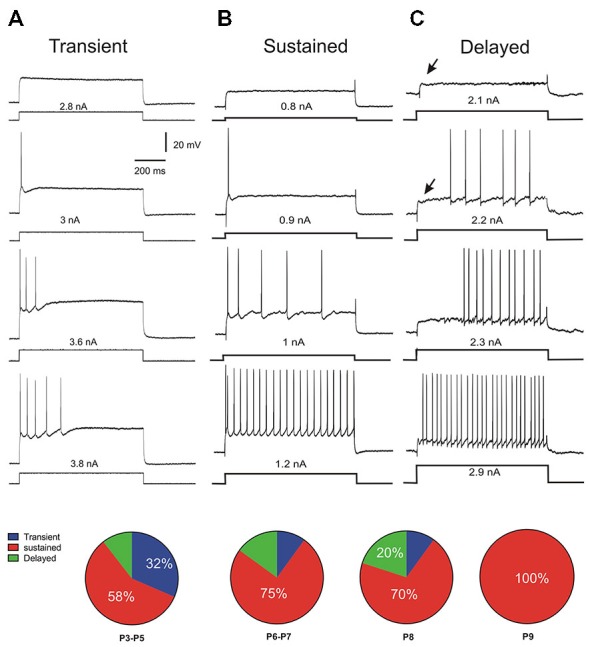
Discharge firing patterns and distributions with age. Three different types of discharge firing patterns were found in lumbar motoneurons (n = 70) at different postnatal ages in response to rectangular current injection. The transient discharge (A) is characterized by a short burst of spike. The sustained pattern (B) starts by an early spiking followed by a burst and discharge firing maintained during the whole pulse. The third pattern is called delayed onset discharge firing (C) the arrow indicating a late depolarization. At P3–P5, one third of motoneurons still present a transient discharge and the motoneuron is not able to fire APs up to the end of the pulse as illustrated in (A) (see pie chart). In older animals the number of motoneurons presenting this pattern decreases up to P9. At that age, there is no more transient firing but all motoneurons exhibit a sustained discharge firing pattern (B). Between P3 and P8 a fraction of motoneurons has a delayed onset firing pattern which disappears at P9.